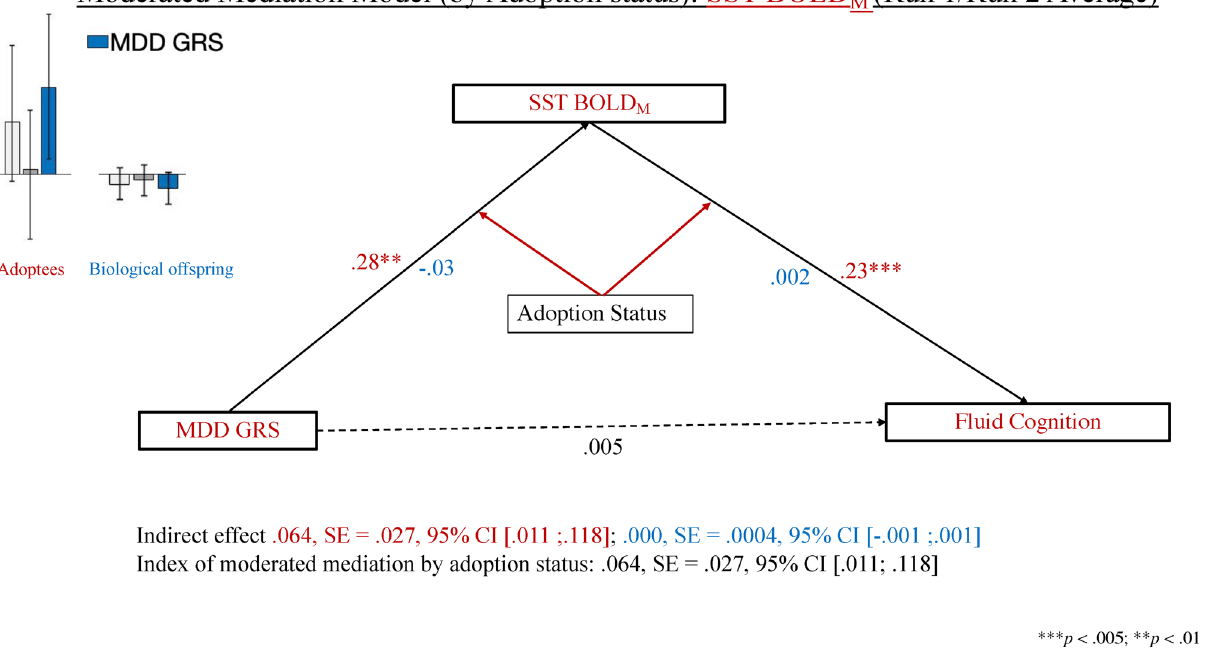
Figure 5. Results of the moderated mediation analysis comparing the effect of the MDD GRS on fluid cognition via average SST BOLD activation among adoptees and non-adoptees. MDD Major Depressive Disorder, GRS genetic risk score, SST Stop-Signal Task, BOLD blood oxygenation level dependent. Coefficients in red font describe the adoptees, those in blue font, the biological offspring, whereas those in black font apply to the full